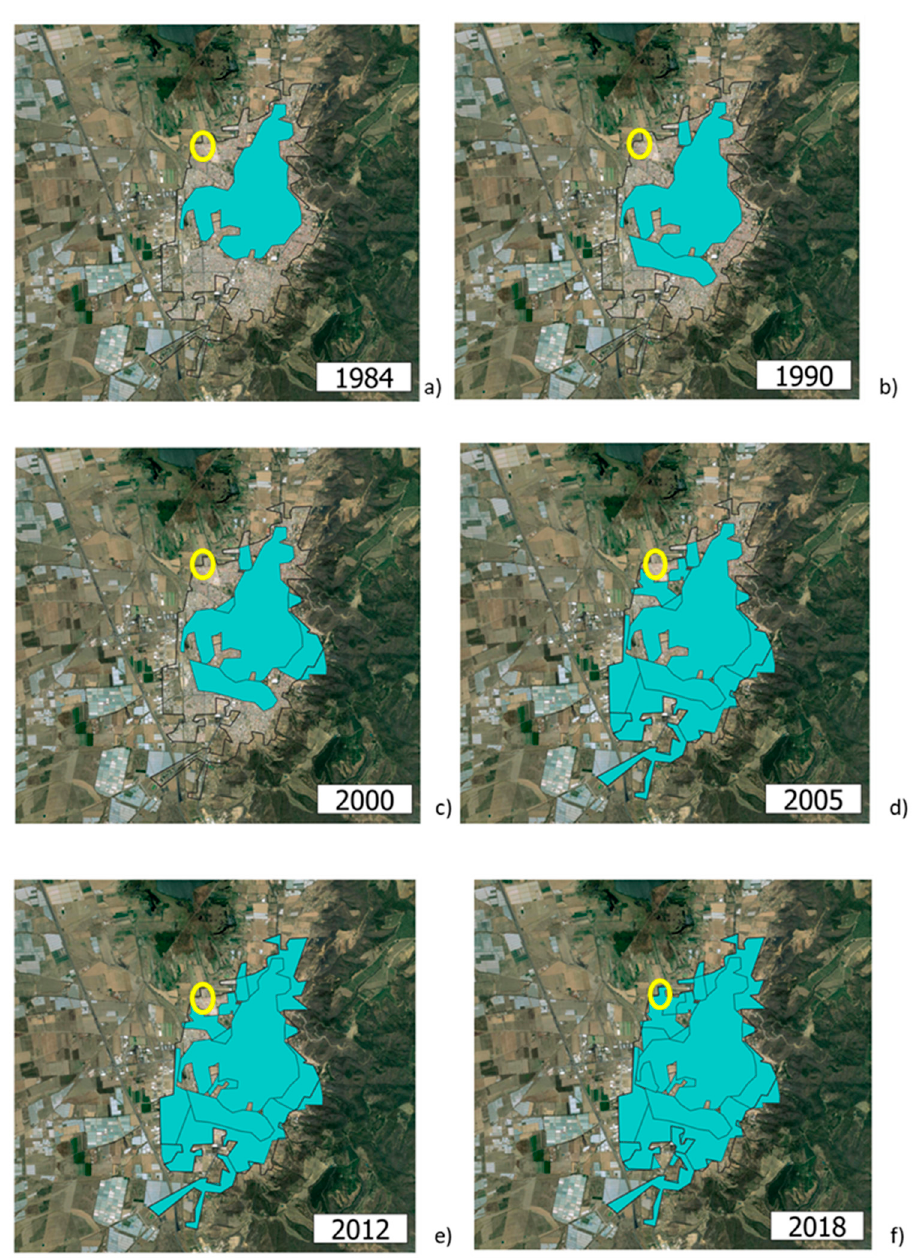
Figure 13. GC growth in the 1984–2018 period ( a – f ). The trends reported in Figure 14 relevant to the urban sprawl experienced by CG are relative to the surfaces evaluated from the polygons reported here. Time series of images with the Google Earth Time Slider tool (Google Earth Pro (v. 7.1.5.1557). Yellow ellipses identify the analysis in this section and reported in Figure 12.